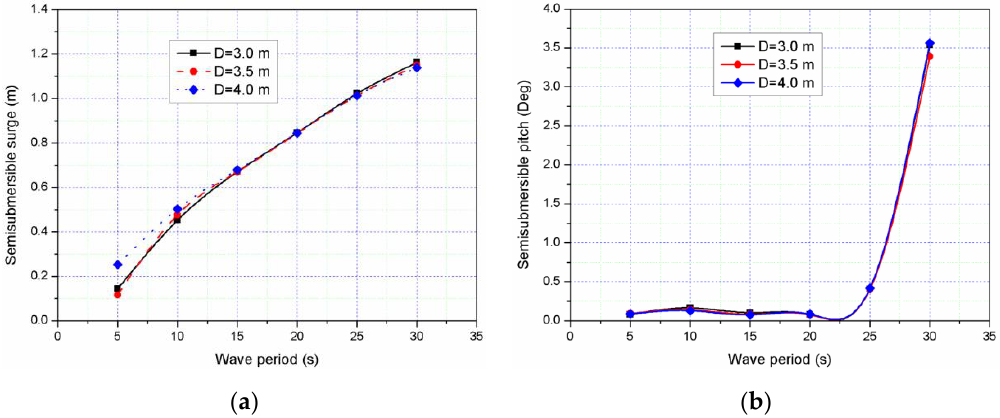
Figure 4. E ff ects of the daft on the WEC: ( a ) semisubmersible surge; ( b ) semisubmersible pitch.